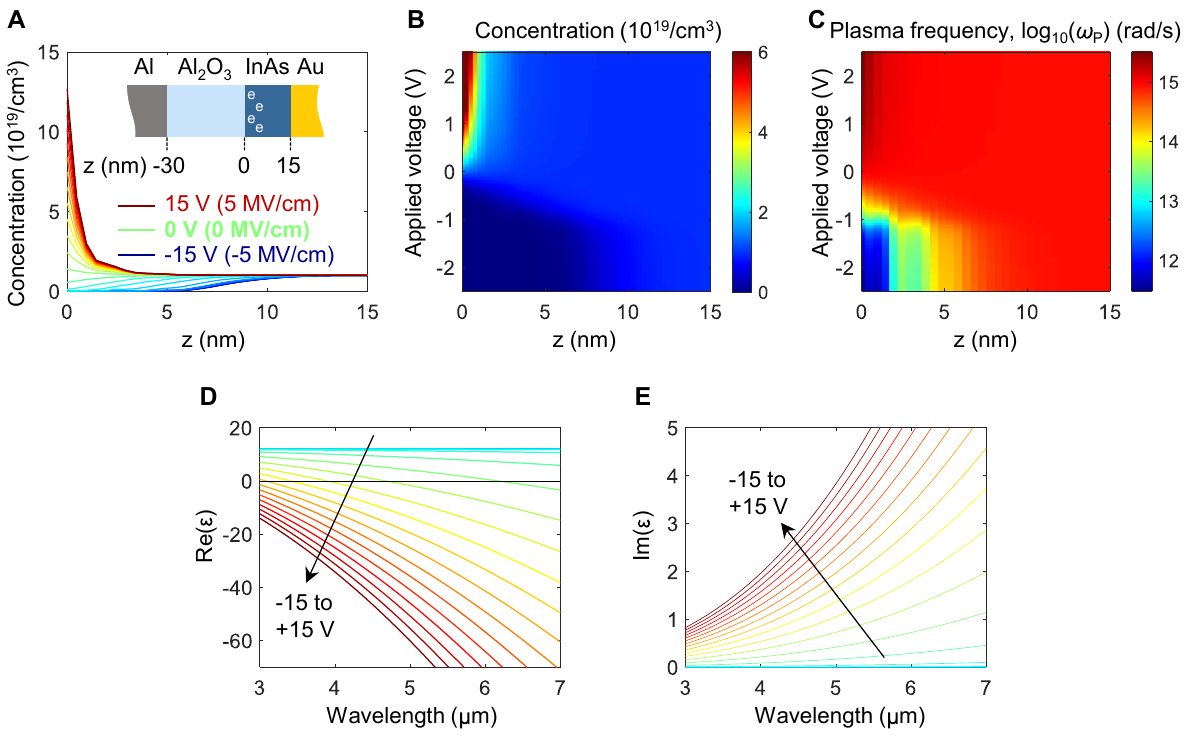
Figure 2: Optical property of the InAs described by the Drude ’ s model. (A) Charge carrier concentration distribution for various voltage values. The inset shows the schematic distribution of the Al/Al 2 O 3 /InAs/Au con fi guration. (B) Charge carrier concentration map for the position and the applied bias. (C) Plasma frequency map in a log scale obtained from (B) and Eq. (2). (D) Real part of the relative electric permittivity at the interface between Al 2 O 3 and InAs layers ( z = 0) for the wavelength range from 3 μ m to 7 μ m for the different bias cases of the depletion (blue, − 5 MV/cm), the no-bias (green, 0 MV/cm), and the accumulation (red, 5 MV/cm). (E) Imaginary part of the relative electric permittivity, showing the negligible optical loss in the depletion case (blue) and signi fi cant increase of the optical loss in the accumulation case